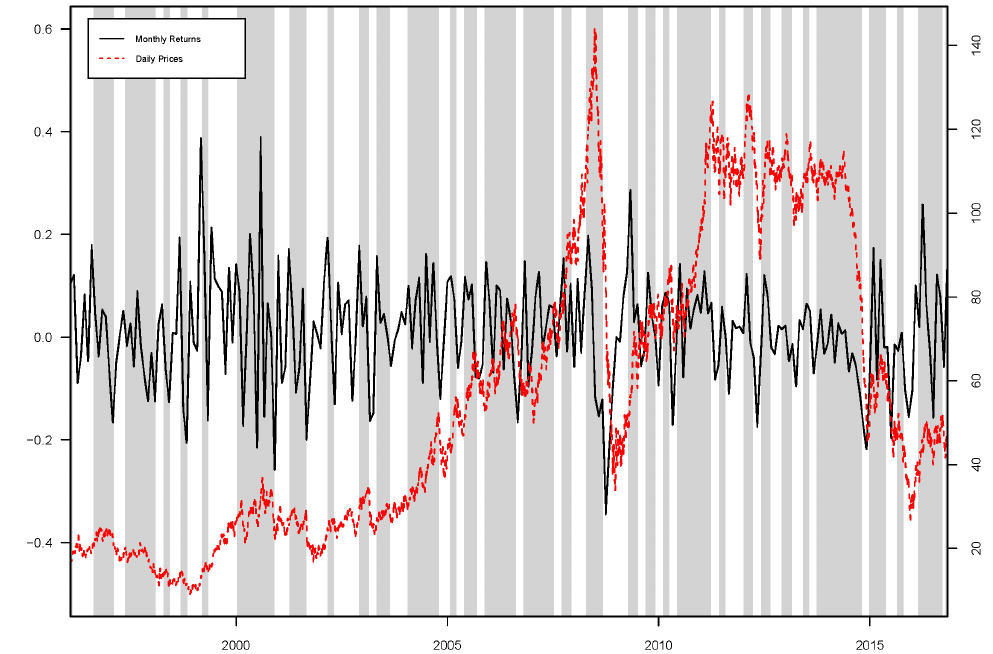
Figure 1. Brent price and monthly return